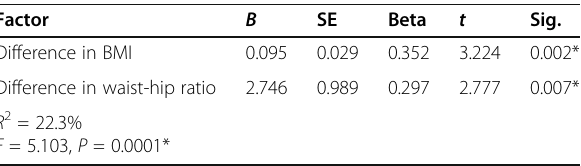
Table 6 Multiple regression analysis of variables associated with change (after-before) in HOMA-IR Factor B SE Beta t Sig. Difference in BMI 0.095 Difference in waist-hip